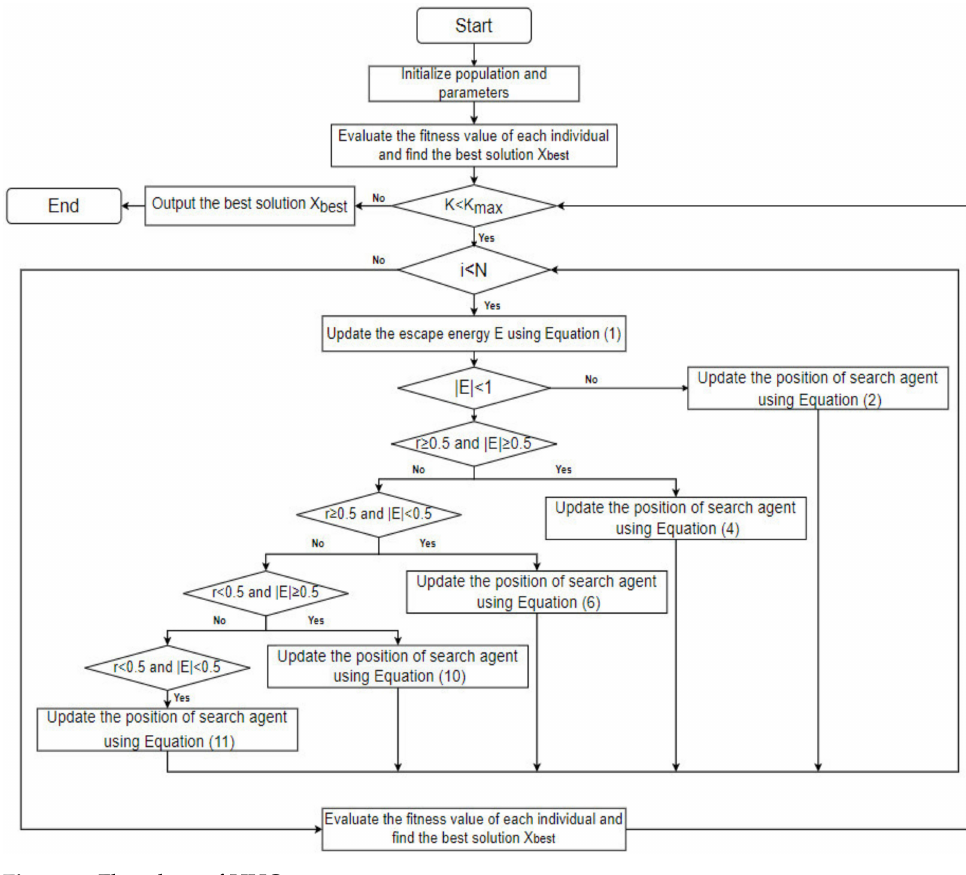
Figure 1. Flowchart of HHO. Algorithm 1 The standard HHO